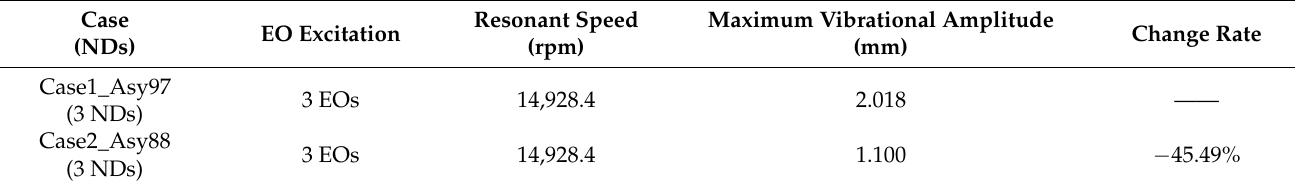
Table 6. Maximum vibrational amplitude in different asymmetric cases.